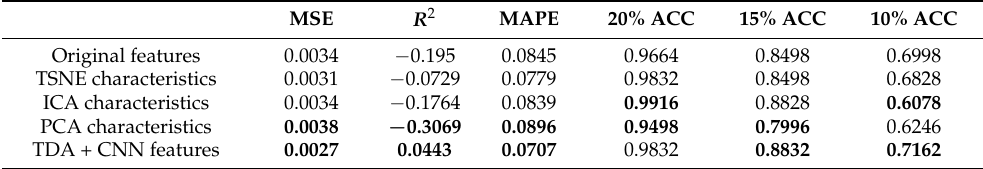
Table 3. Comparison of original features, PCA features, ICA features, TSNE features, TDA + CNN features. MSE R 2